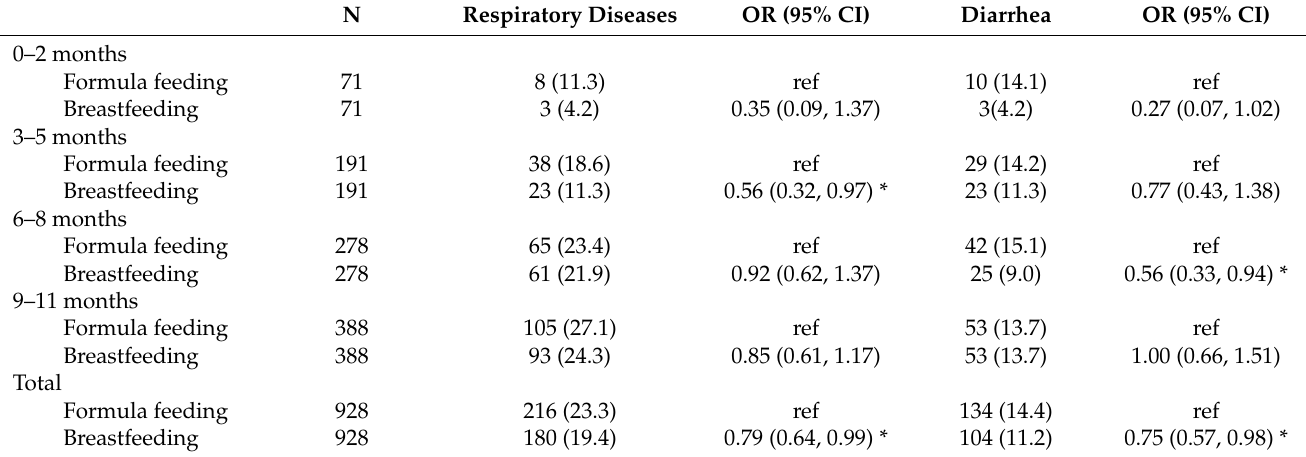
Table 3. Association between breastfeeding and prevalence of respiratory diseases and diarrhea in the last two weeks, N (%).